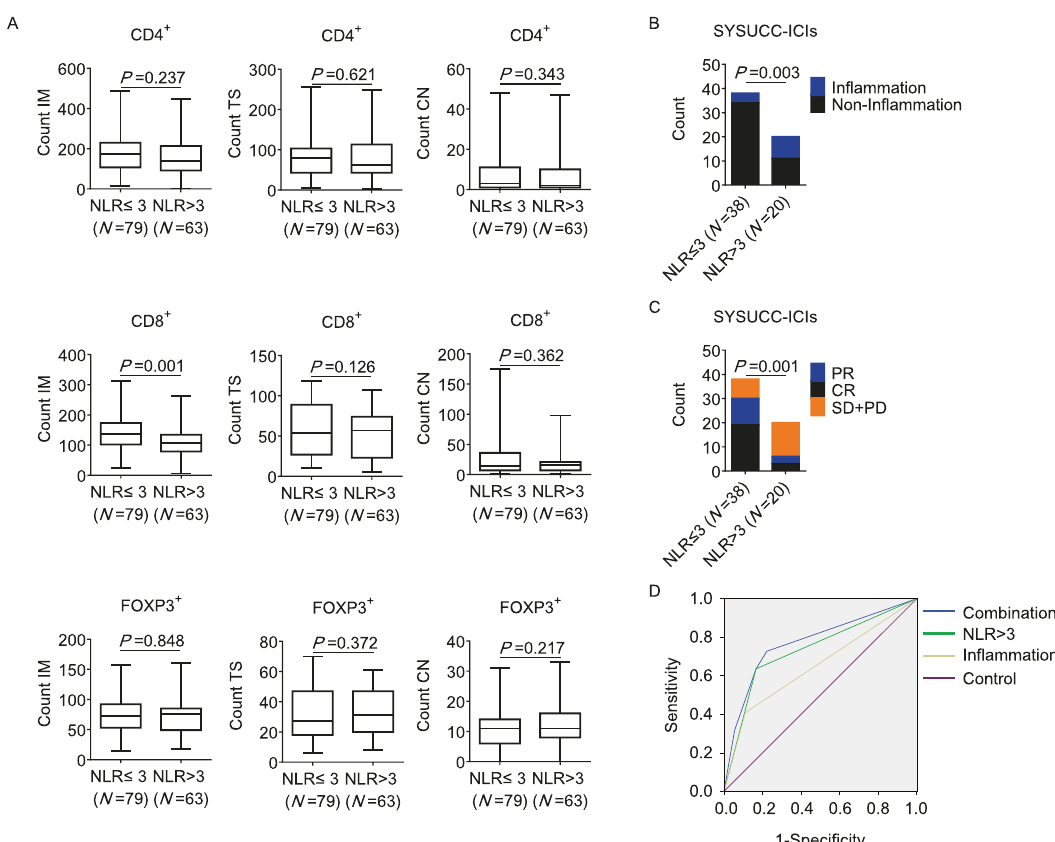
Fig. 4 | Elevated NLR is associated with poor immune status and resistance to ICIs. A In a cohort of 142 surgically resected dMMR CRCs, the CD4 + , CD8 + and FOXP3 + TILs in the IM, TS and CN were compared between patients with NLR ≤ 3 ( N =79) and NLR>3 ( N =63). The two-tailed unpaired Mann-Whitney U